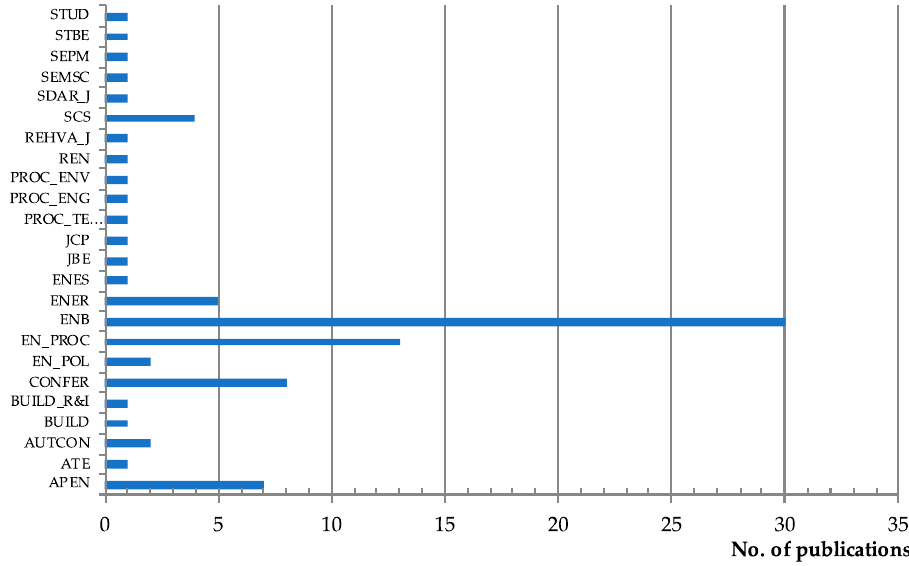
Figure 7. Cost-optimal studies by publication type. (Legend: APEN = Applied Energy; ATE = Applied